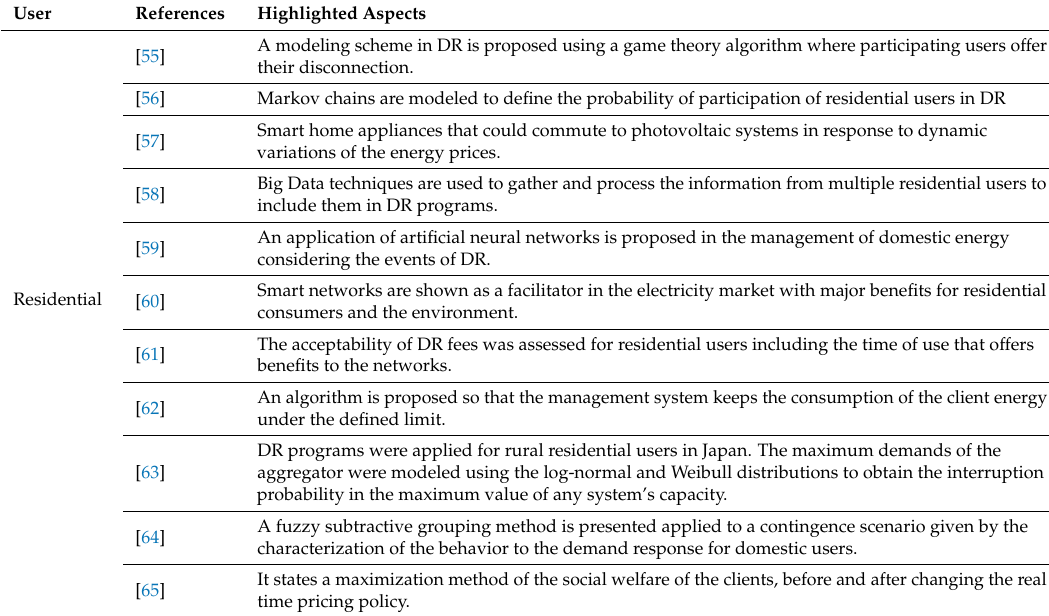
Table 2. DR programs for different types of